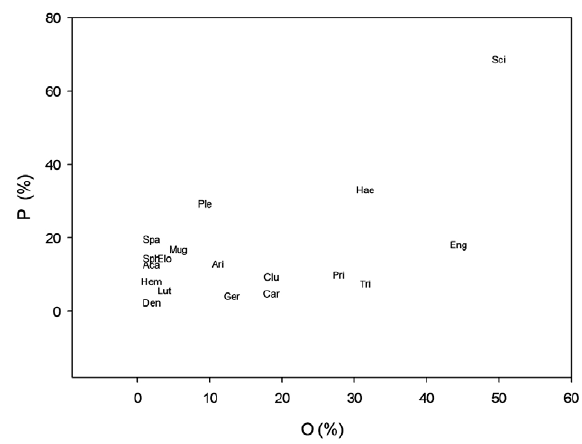
Fig. 2. – Costello graphical representation showing the relative im- portance and dominance of the prey. Axis X refers to the frequency of occurrence (O) and axis Y to the specific prey relative abundance (P), both measures expressed as a percentage. Prey acronyms are as follows: Ari, Ariidae; Car, Carangidae; Clu, Clupeidae; Den, Dendrobranchiata; Elo, Elopidae; Eng, Engraulidae; Ger, Ger- reidae; Hae, Haemulidae; Hem, Hemiramphidae; Lut, Lutjanidae; Mug, Mugilidae; Ple, Pleuronectiformes; Pri, Pristigasteridae; Sci, Sciaenidae; Spa, Sparidae; Sph, Sphyraenidae; Tri, Trichiuridae.